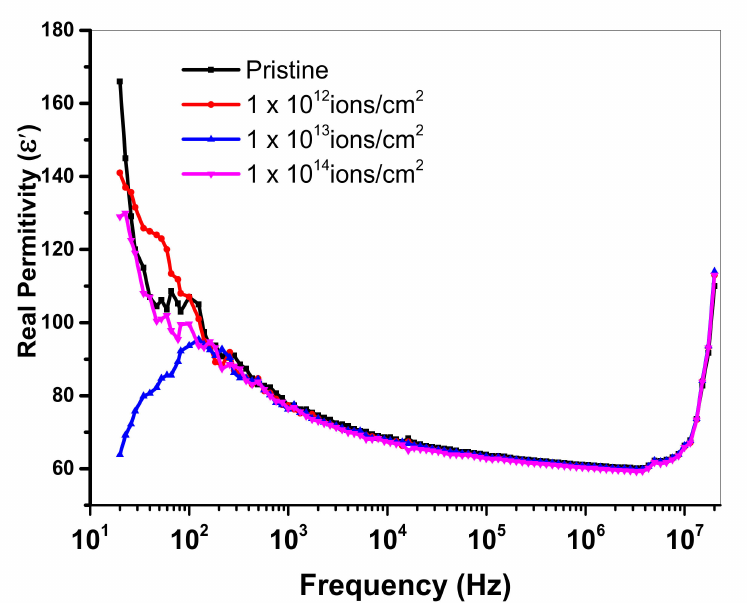
Figure 10. Variation in the real part of dielectric constant ( ε (cid:48) ) with frequency.